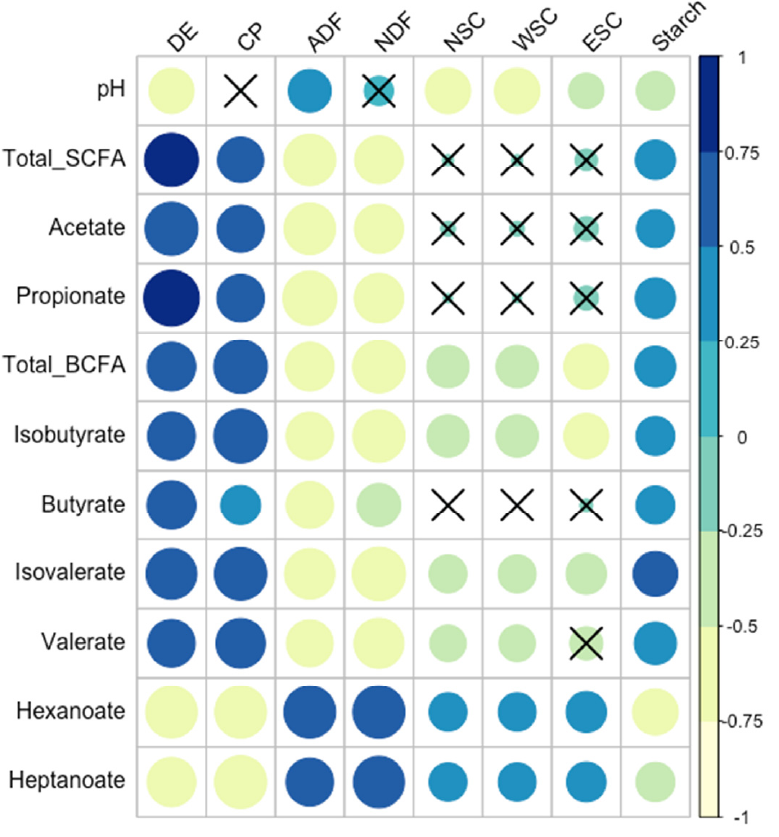
Figure 6. Correlation of forage nutrients and fermentation metabolites. Nutrients included digestible energy (DE), crude protein (CP) acid detergent fiber (ADF), neutral detergent fiber (NDF), non- structural carbohydrate (NSC), water-soluble carbohydrate (WSC) and ethanol-soluble carbohydrate (ESC). Significance of Spearman correlations was set at r s ≥ |0.30| ( p ≤ 0.05). Cells with an “X” indicate non-significant correlations. Color and size of circles within cells are mapped to direction and strength of correlation. Larger, darker blue circles indicate a stronger positive correlation (closer to r s = 1.0); larger, lighter yellow circles indicate a stronger negative correlation (closer to r s = −